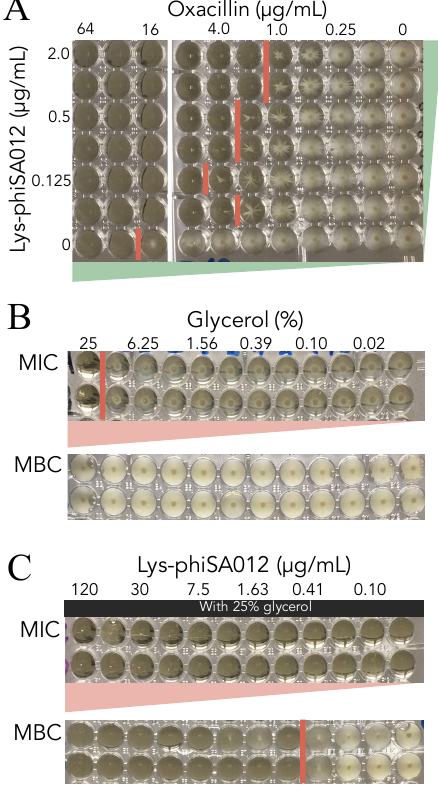
Figure 5. MIC and MBC assays. MIC and MBC assays were performed in 96-well plates. Red lines indicate the border of bacterial growth. ( A ) MIC assay of oxacillin towards SA003 with or without Lys-phiSA012. ( B ) MIC and MBC assays of glycerol towards SA003. ( C ) MIC and MBC assays of Lys-phiSA012 with 25% glycerol towards